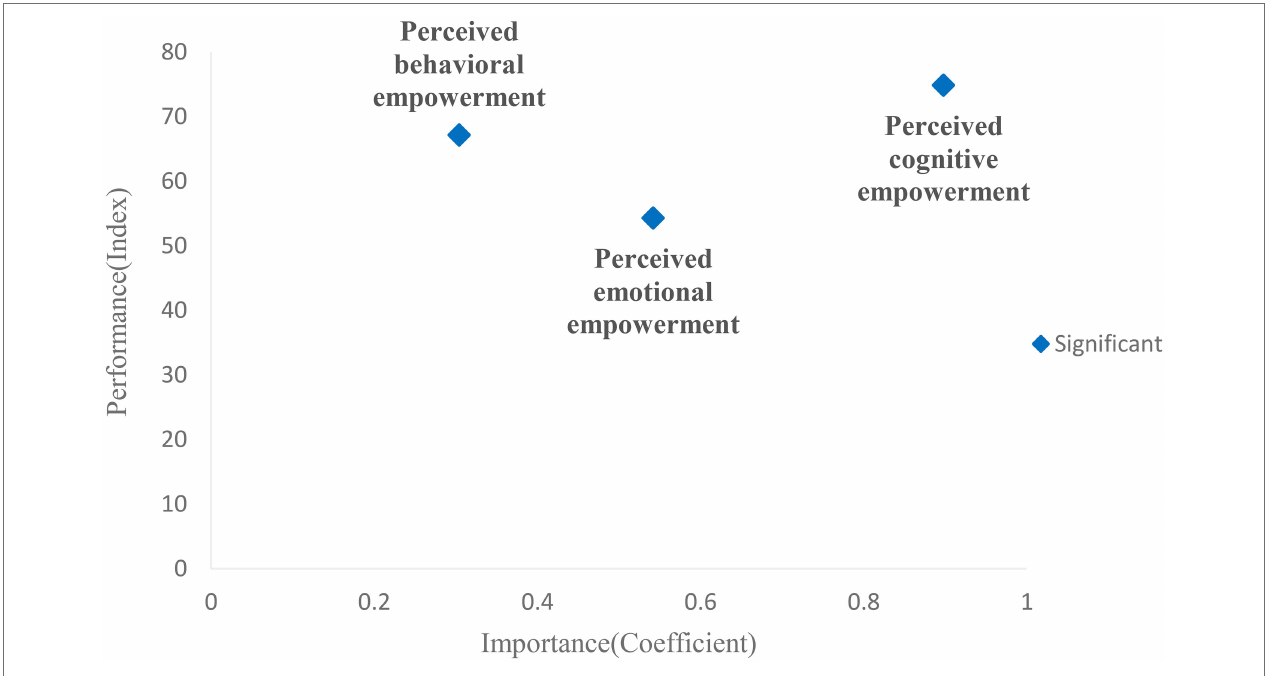
FIGURE 3 | Importance-performance